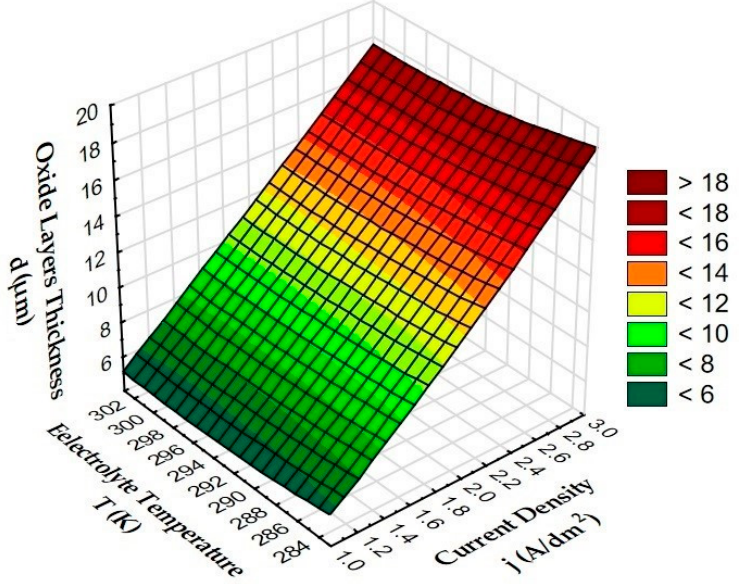
Figure 7. Dependence of the oxide layers thickness of oxide layers on the current density and elec- trolyte temperature.